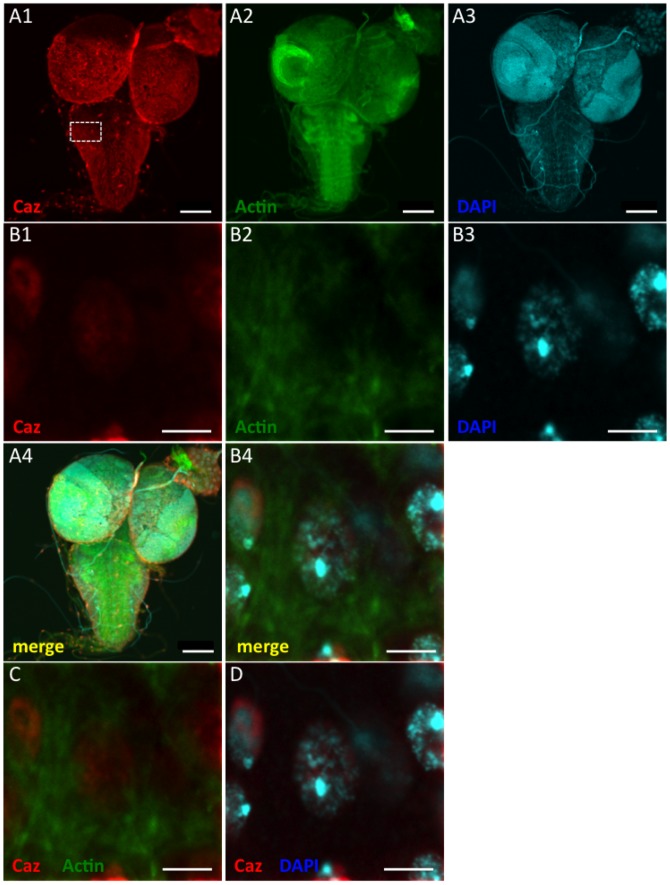
Intraneuronal localization of Caz in larval brains.Brain-ventral ganglia complexes from third instar larvae (A–D) were stained with the anti-Caz antibody (A-1, B-1), diamino-2-phenylidole (DAPI) (nuclear staining; A-2, B-2) or phalloidin (F-actin staining; A-3, B-3). Panels B-1 to B-4 are higher magnification images of the boxed area in A-1. Merged confocal images of A-1 to A-3, B-1 to B-3, B-1 and B-2, and B-1 and B-3 are shown in A-4, B-4, C, and D, respectively. The bar indicates 100 μm (A) or 5 μm (B–D). Anti-Caz antibody-immunoreactivity was detected in the nucleus of neuronal cells and did not co-localize with actin filaments, which stained with phalloidin. Since Caz did not co-localize with DAPI, which stains chromosomes, Caz must therefore localize in the nucleoplasm.